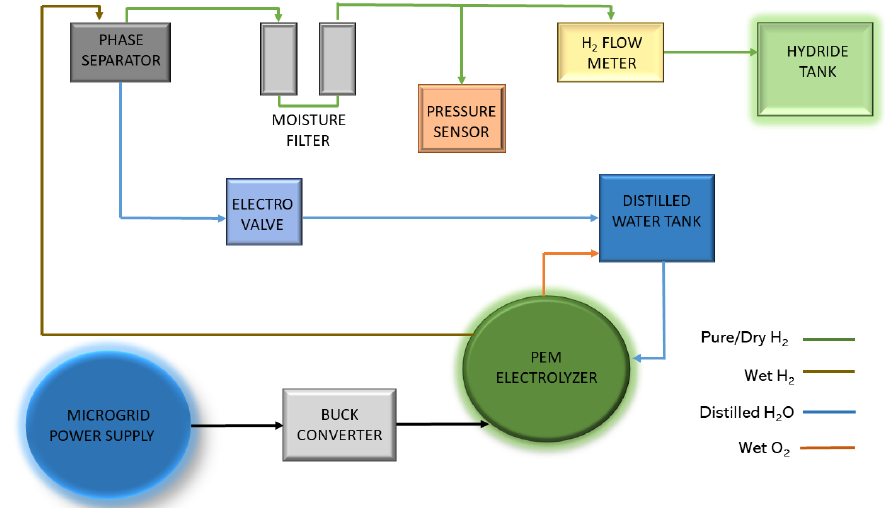
Figure 2. PEMEL hydrogen generation